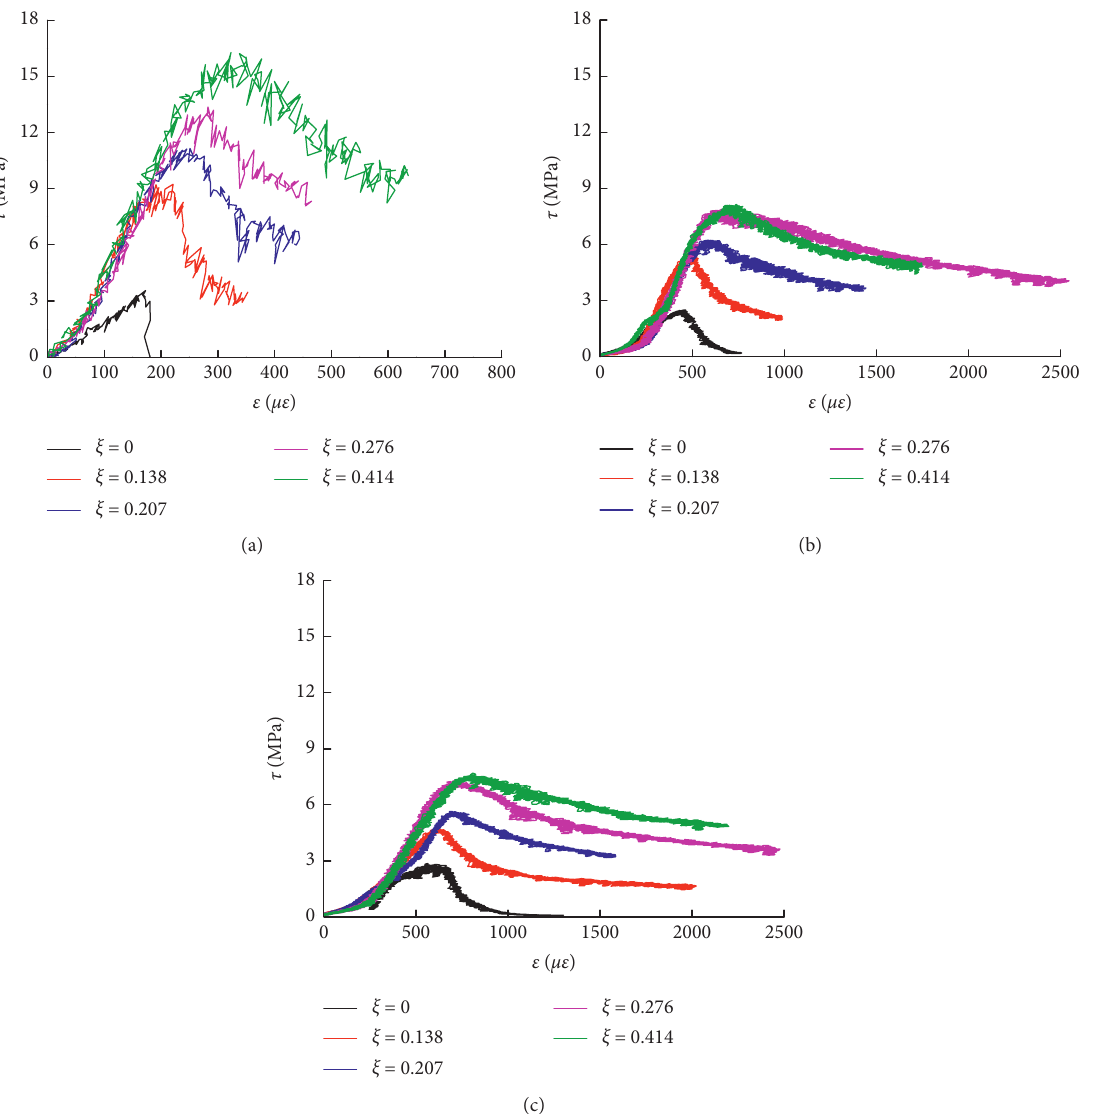
Figure 8: The shear stress-strain curve of rubber fiber concrete. (a) C-0%-0%. (b) C-30%-0%. (c)